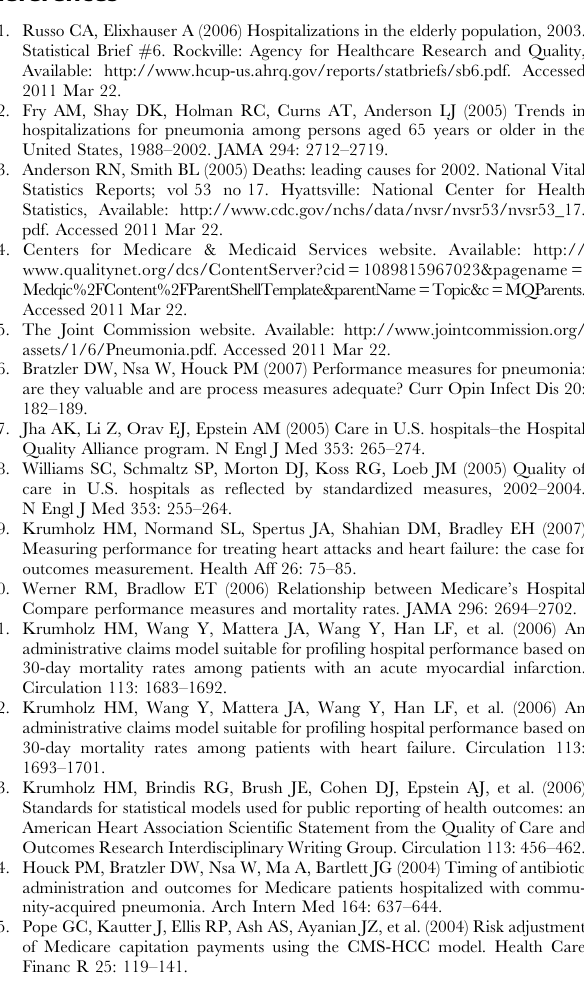
Table S2 Covariates from Hierarchical Generalized Linear Model (HGLM) included in the final administrative claims model to predict 30-day mortality. Table S3 Pneumonia administrative model and medical record model performance. Table S4 Covariates included in the final medical records model